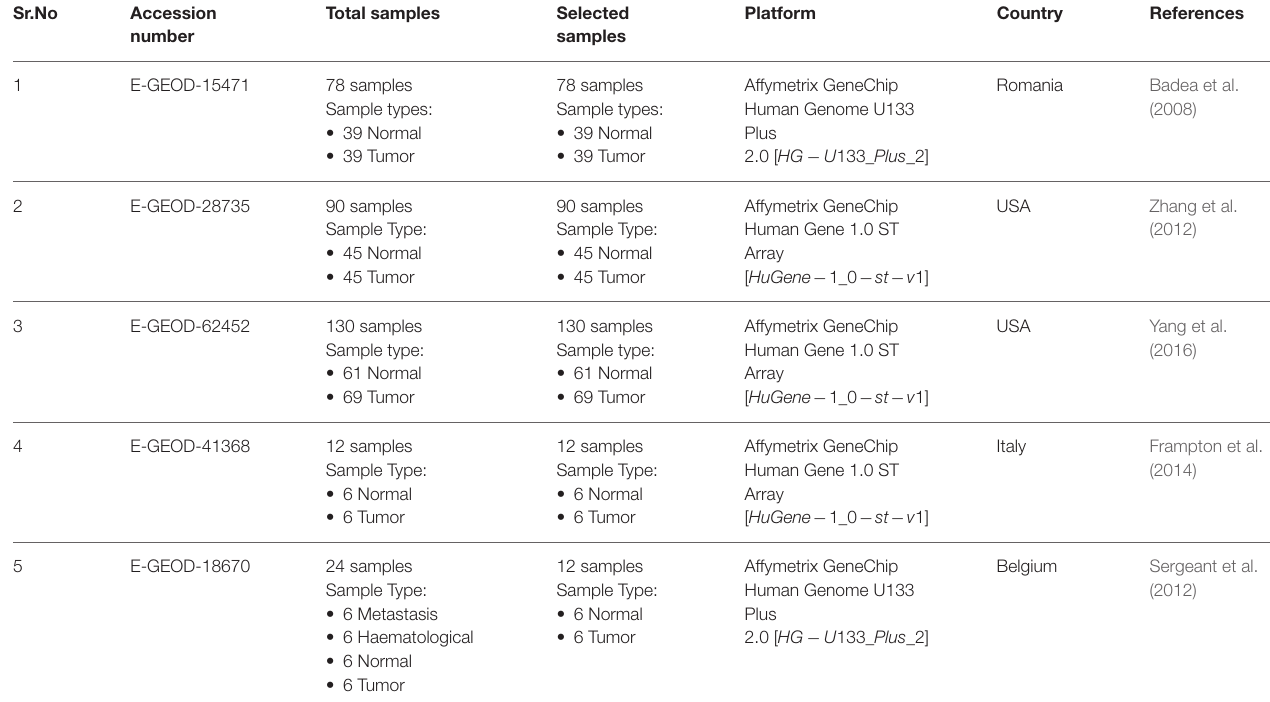
TABLE 1 | Microarray datasets.